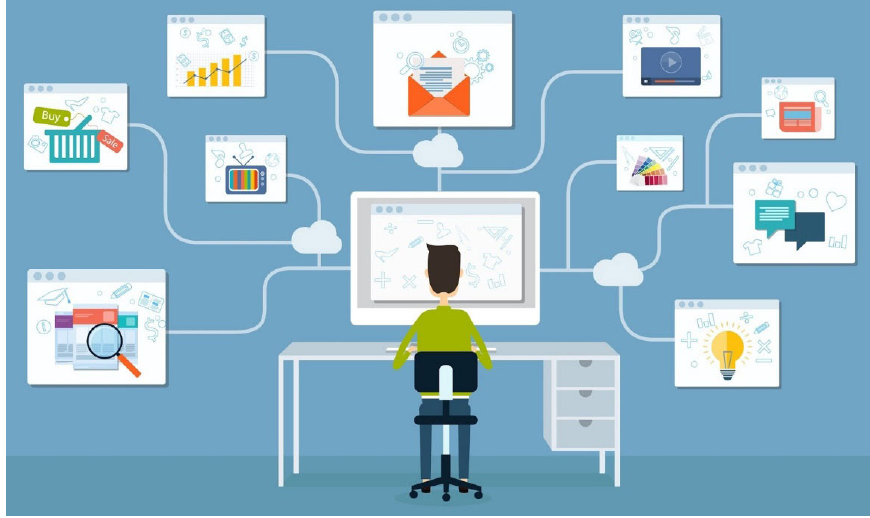
Fig. 1. Types of E-learning